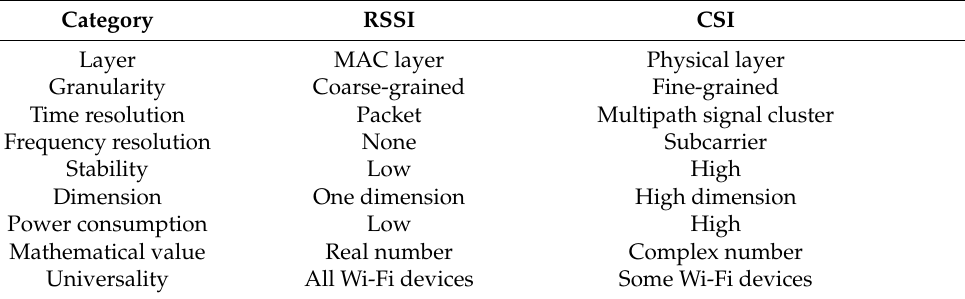
Table 1. Compare the difference between received signal strength indication (RSSI) and channel state information